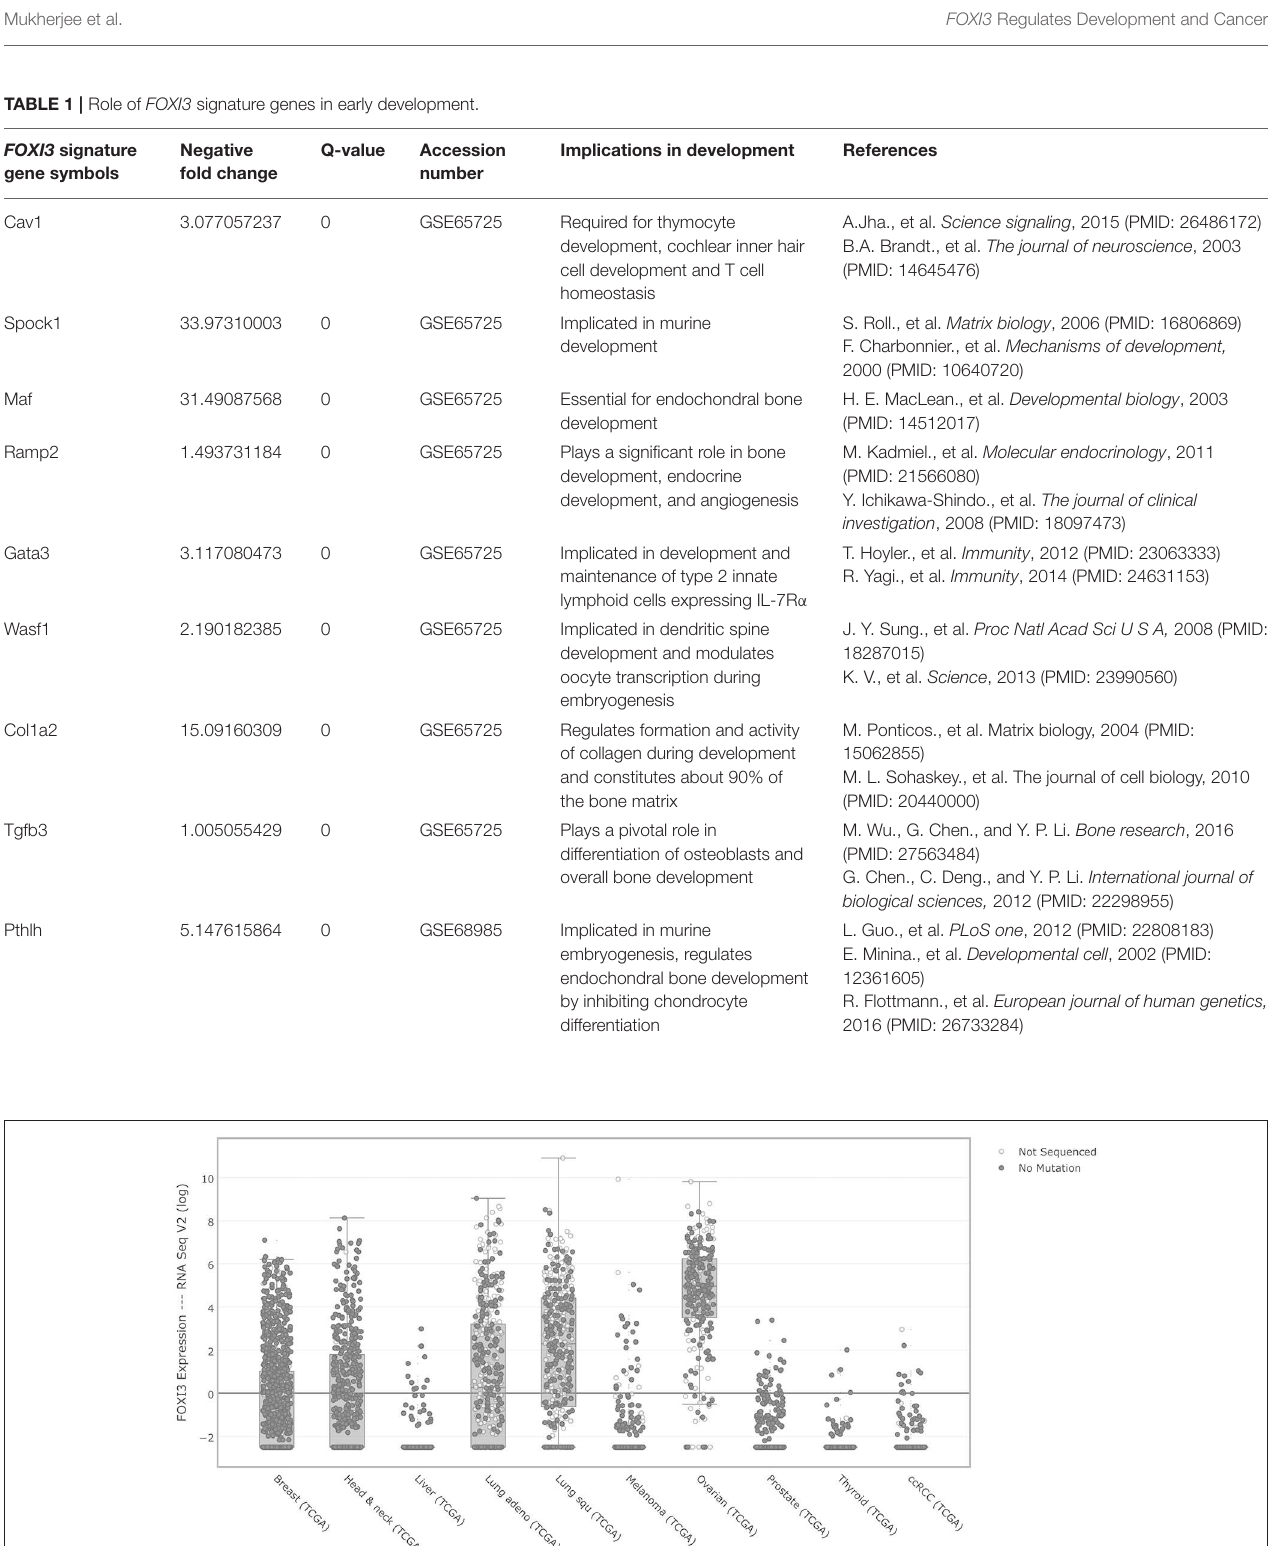
Frontiers in Cell and Developmental Biology |